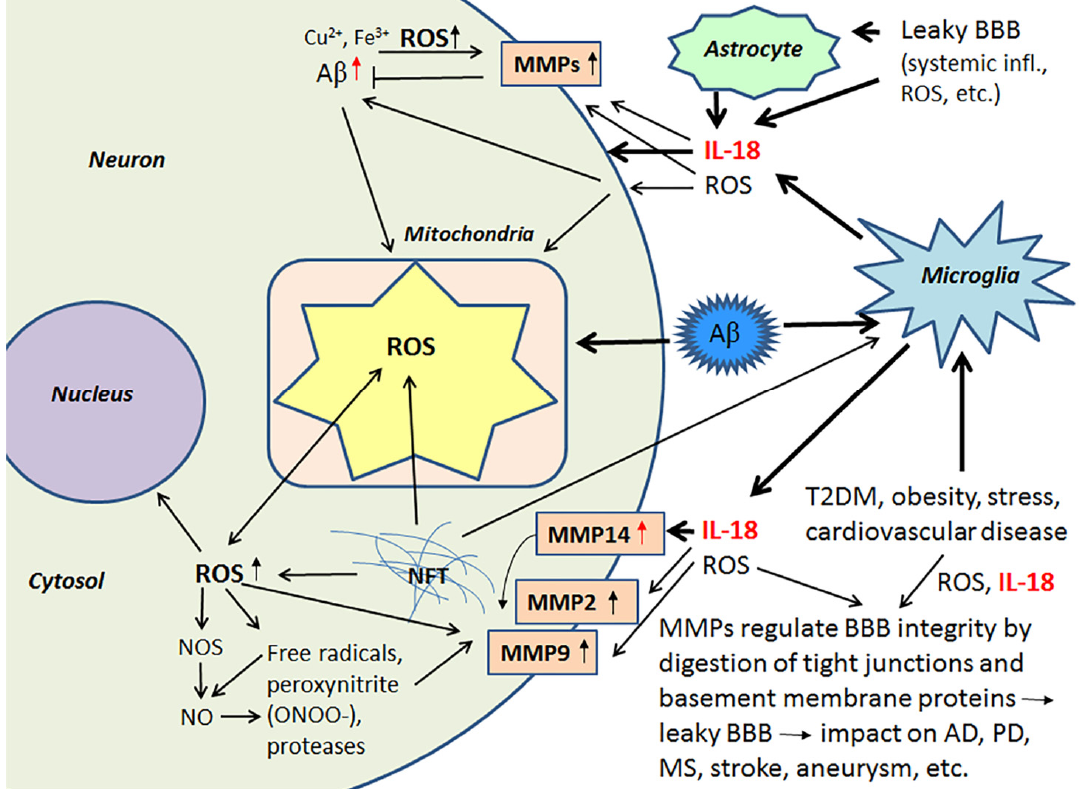
Figure 4. The multiple roles of MMPs in neurodegeneration. ROS are powerful inducers of MMPs, and induction can lead to leakage in BBB with harmful consequences. On the other hand, MMPs can degrade A β and reduce ROS production. Red arrow, target regulated by IL ‐ 18 [40,42].